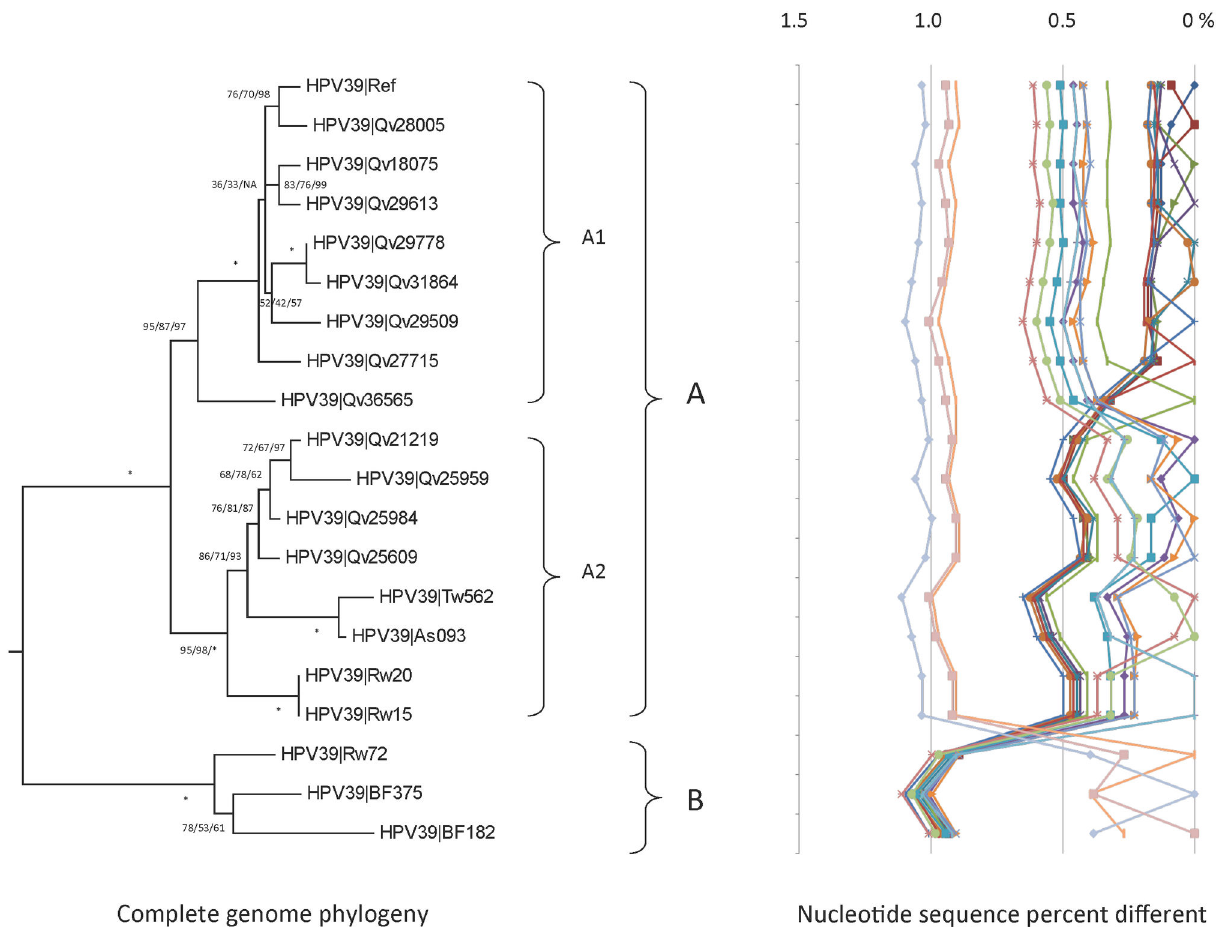
Figure 3. HPV39 variant tree topology and pairwise comparisons of individual complete genomes. The phylogenetic tree was constructed as described in Figure 2. Distinct variant lineages and sublineages were determined as described in Figure 2. The percent nucleotide sequence differences are shown in the panel to the right of the phylogenetic tree as described in Figure 2. doi: